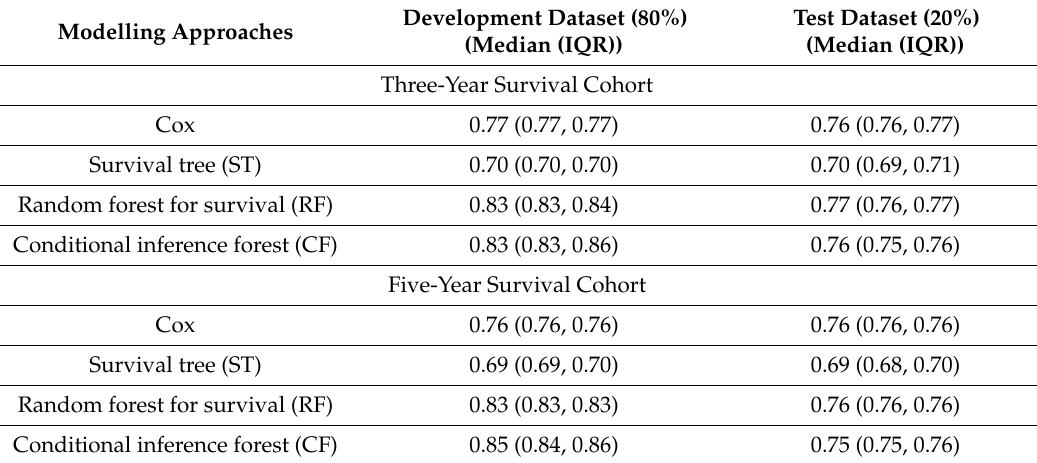
in Table 3. In the main text, we present results from complete case analysis for the 8:2 split of the model development and test datasets. Results for the imputed datasets and any other splits can be found in Table S4 and Figures S1–S3. Table 3. C-index in the development and test datasets for various models for predicting 3- and 5-year disease-specific survival of oral and pharyngeal cancers based on the complete case analysis.